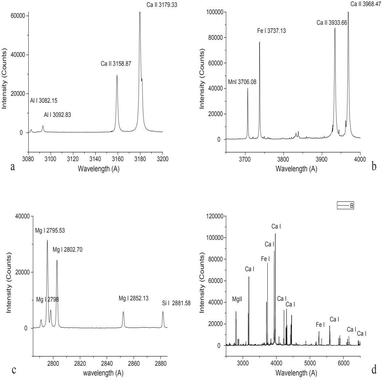
LIBS analysis of the Gypsum sample.